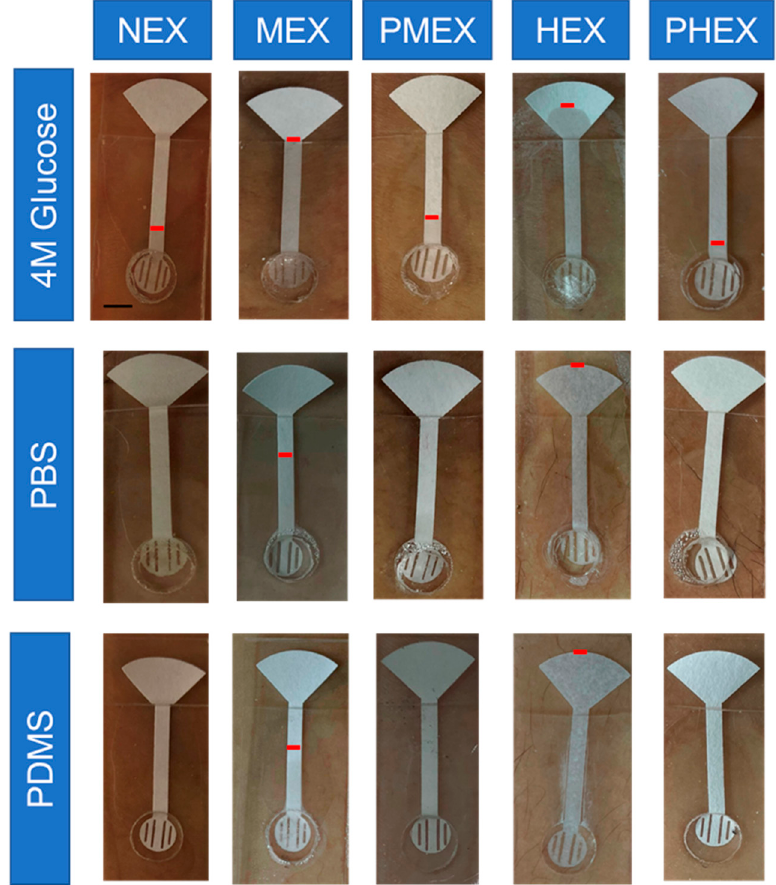
Figure 3. Optical images of the patch on skin showing the levels of sweat collection on the paper channel of patches with different pumping materials under different physiological conditions. The red mark on the paper channel indicates the position of sweat after each trial. Scale bar = 5 mm.